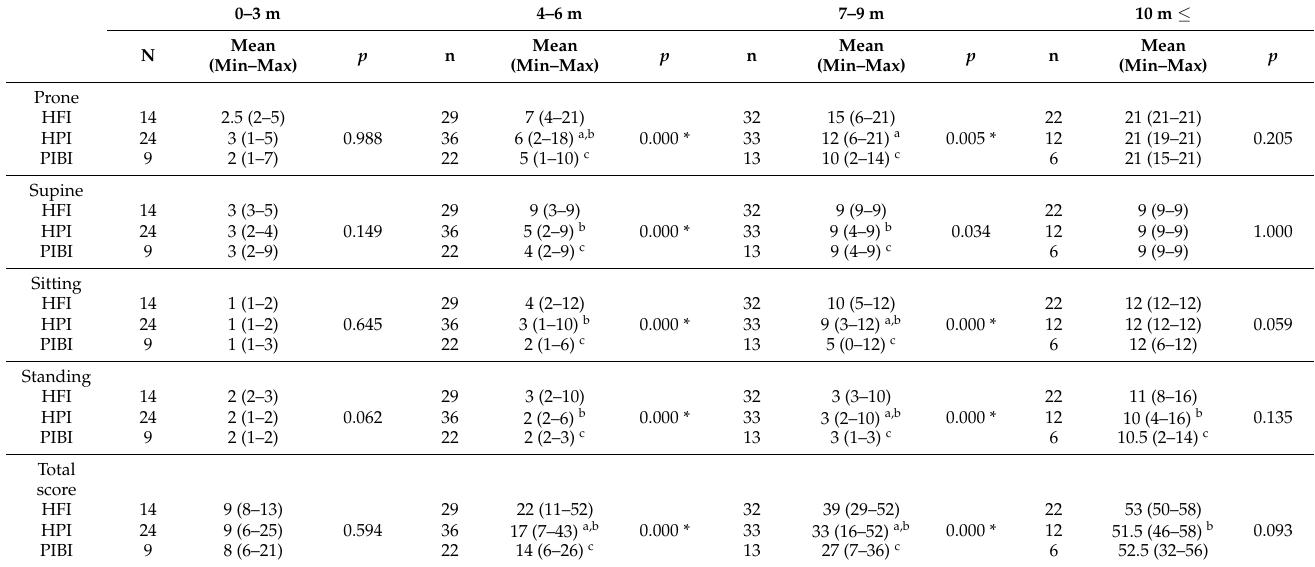
Table 2. Alberta Infant Motor Scale (AIMS) positional and total scores differences by groups at four different ages (n =